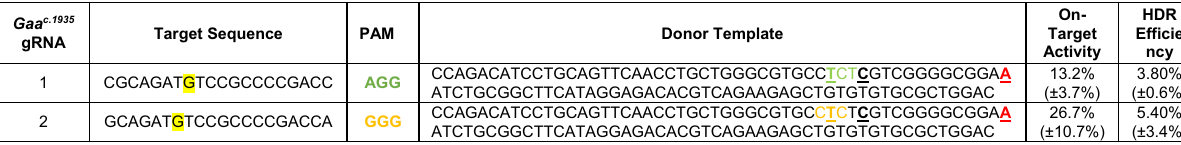
Table 1. Gaa c.1935 guide RNA on-target activity and HDR efficiency. The target sequence, PAM motifs and donor templates used for testing of Gaa c.1935 guide RNAs in C2C12 mouse mybloasts are outlined. Gaa c.1935 locus for each gRNA target sequence is highlighted in yellow. Desired Gaa c.1935 KI mutation (red), silent PAM site (either green or gold, corresponding to gRNA) and gRNA seed region (black) mutations are bolded and underlined in the donor template sequence. Total on-target Cas9 nuclease activity and HDR efficiency for each Gaa c.1935 guide RNA condition is displayed as the average of two independent